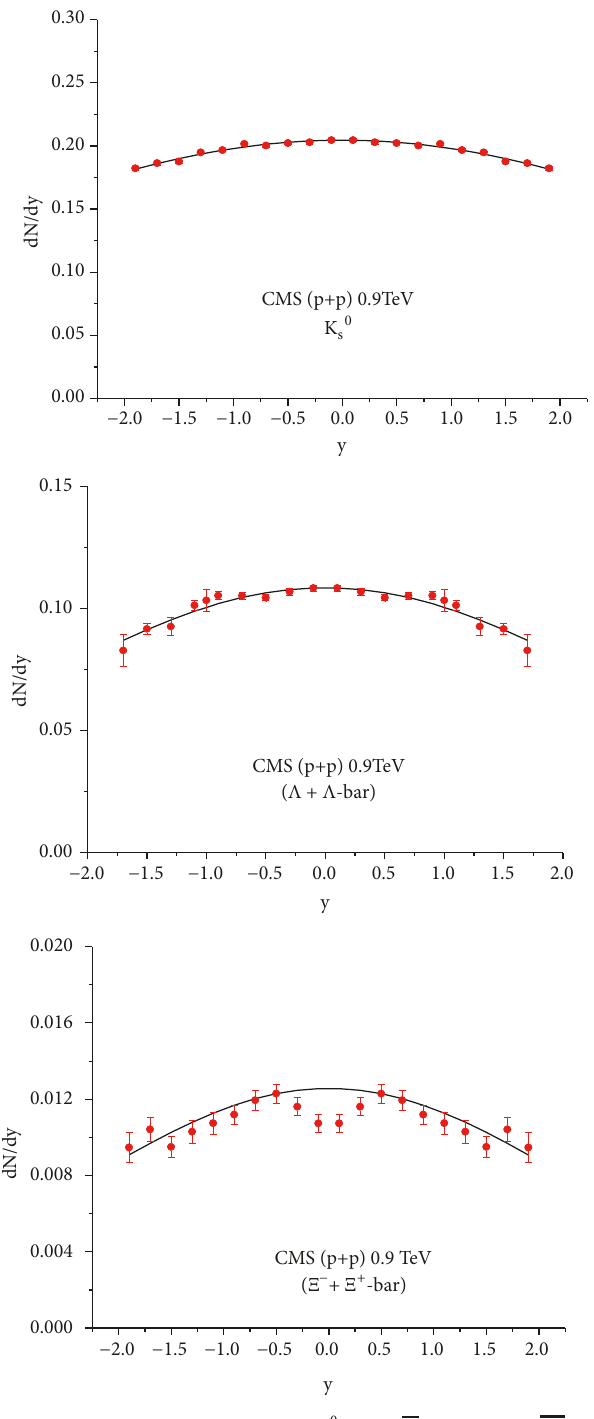
Figure 1: Rapidity distribution of 𝐾 0 𝑠 , (Λ + Λ) , and (Ξ − + Ξ + ) at √ s NN =0.9 TeV.